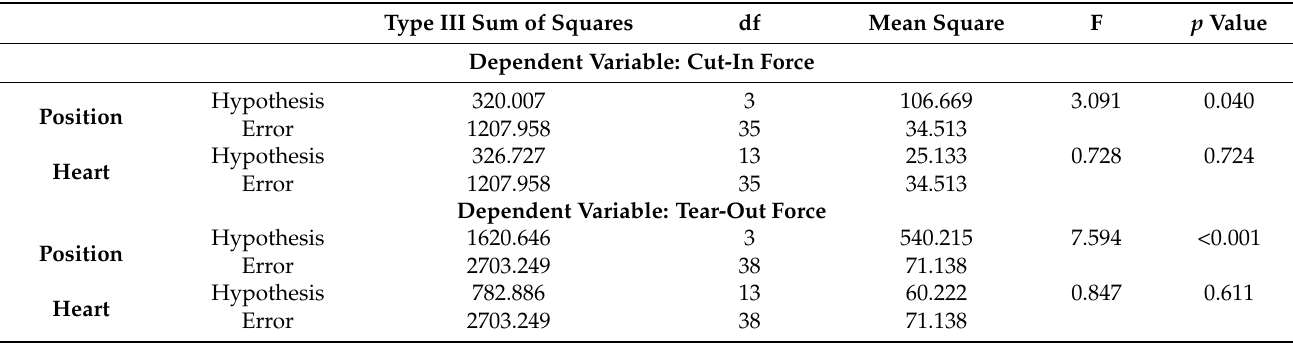
Table 2. Results of the univariable two-factorial ANOVA (Analysis of variance). Type III Sum of Squares df Mean Square F p Value Dependent Variable: Cut-In